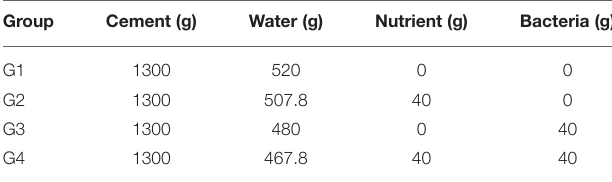
TABLE 1 | Composition of the specimens in each